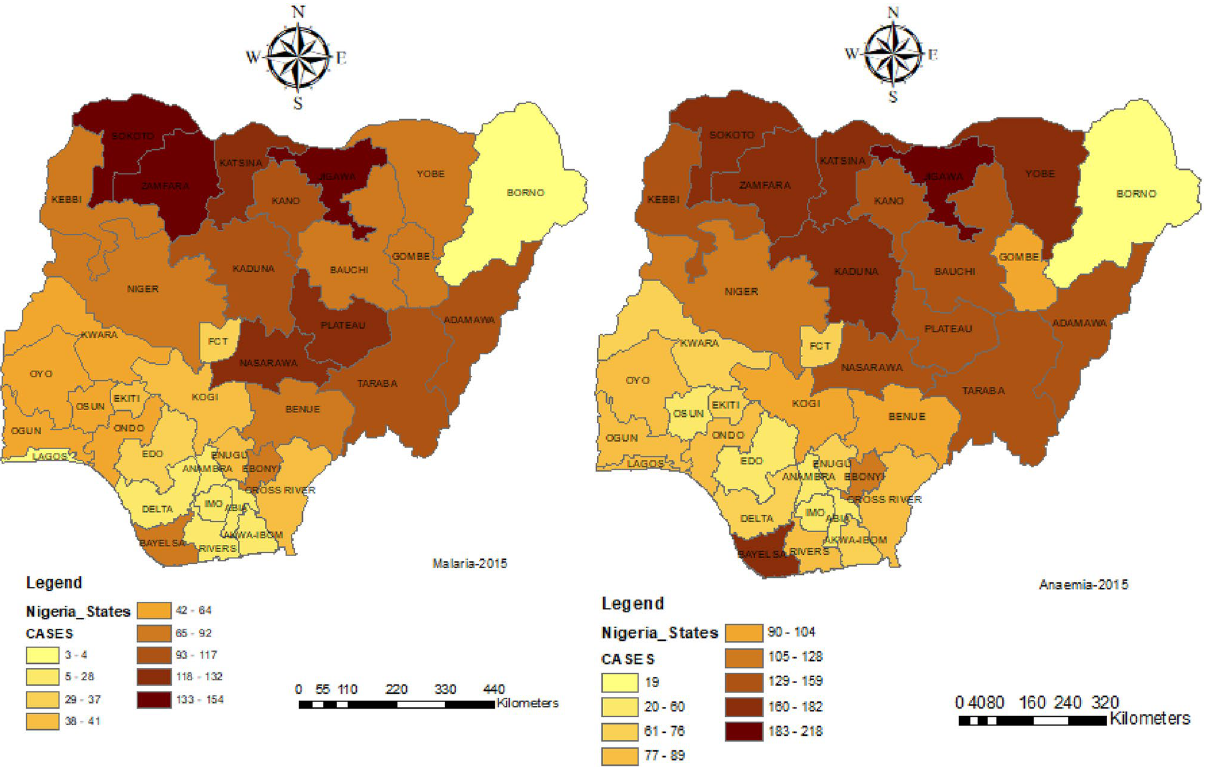
Figure 2. The 37 states including the capital territory of Nigeria showing the 2015 prevalence of malaria and anaemia of under-5 years of children.